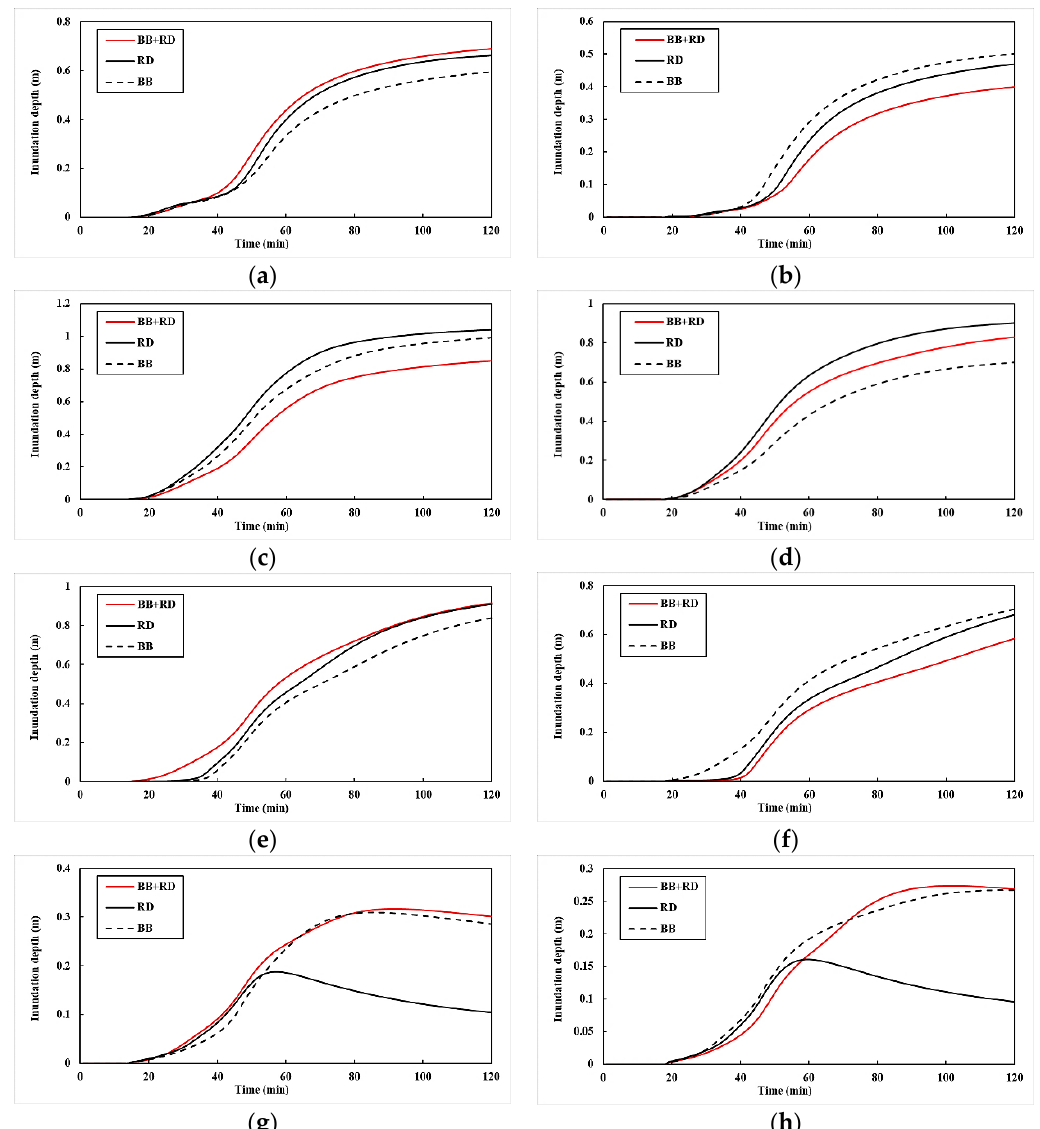
Figure 12. The inundation depth as a function of time when using the BB, RD, and BB + RD methods at four observation points: ( a , c , e , g ) 10-year return period; ( b , d , f , h ) 2-year return period.